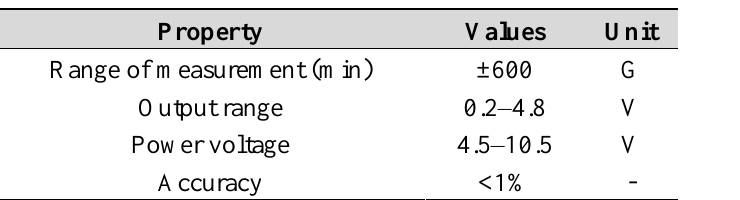
Table 2. Table of performances of the sensor Honeywell SS495A1 employed for the experimental